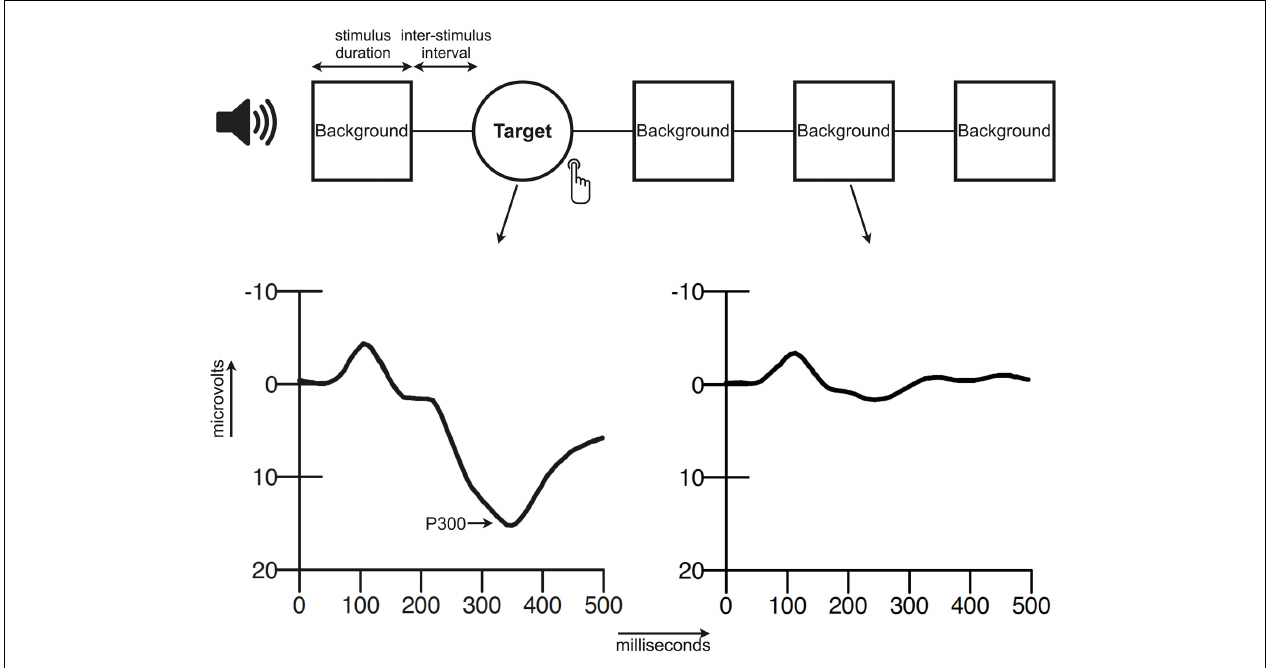
FIGURE 1 | Schematic overview of the oddball paradigm and an ERP.